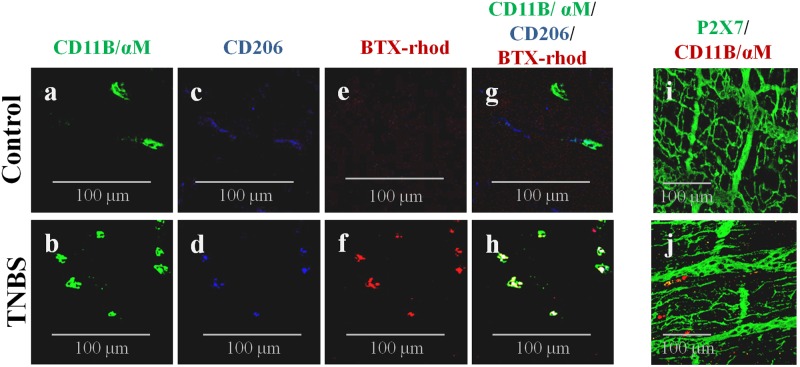
CD11B-immunoreactive inflammatory cells surrounding myenteric ganglia and infiltrating the intramuscular layer of TNBS-treated rats also stain positively against CD206 (a cell marker of anti-inflammatory M2 macrophages) and tetramethylrhodamine-conjugated α-bungarotoxin (BTX-rhod) identifying α7 subunit-containing nicotinic receptors both in Control (a,c,e,g) and TNBS-treated (b,d,f,h) rats. Confocal micrographs of whole-mount preparations of the longitudinal muscle-myenteric plexus of the ileum of Control (i) and TNBS-treated (j) rats show that CD11B-positive cells do not express the P2X7 receptor. Images are representative of at least four animals per group. Scale bar = 100 μm.